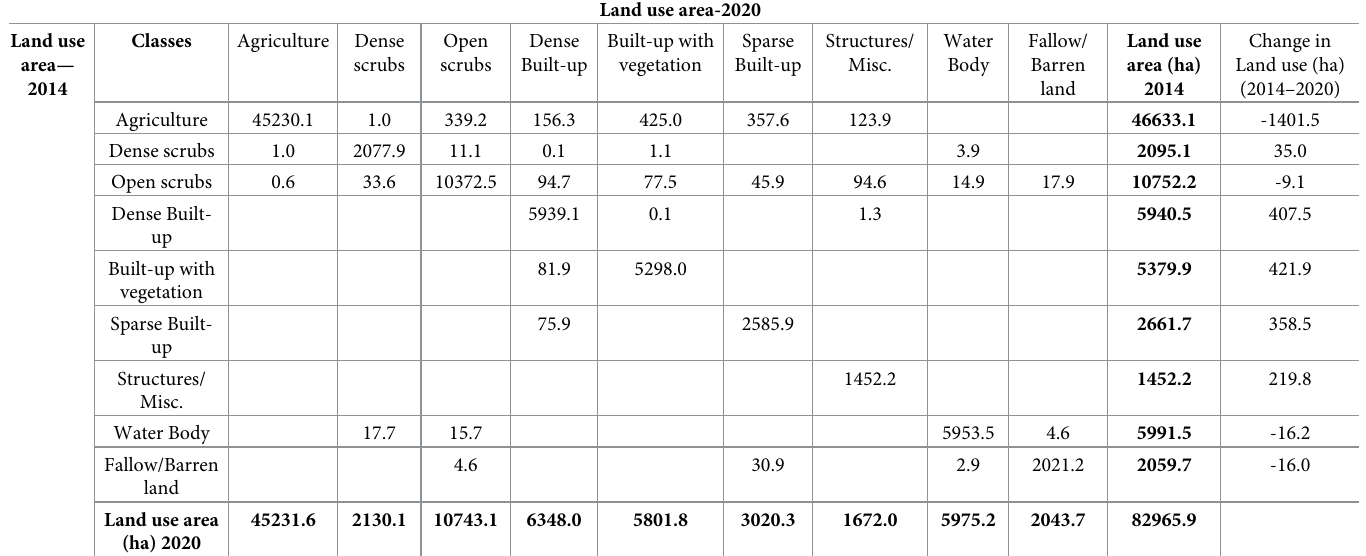
Table 2. LULC Matrix for changes in hectares (ha) in different land cover class (2014 to